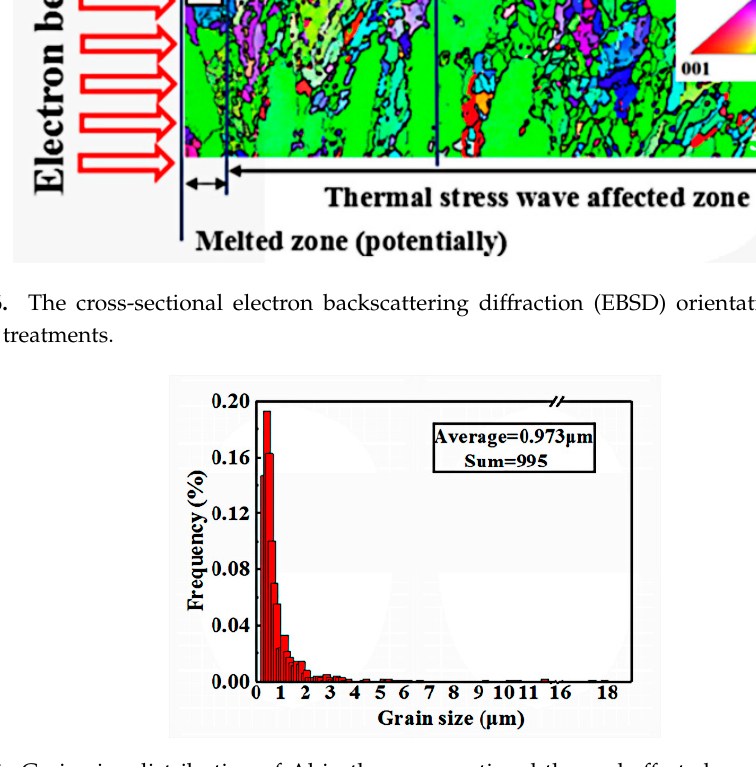
Figure 7. Grain size distribution of Al in the cross-sectional thermal-affected zone after 25 pulse treatments.